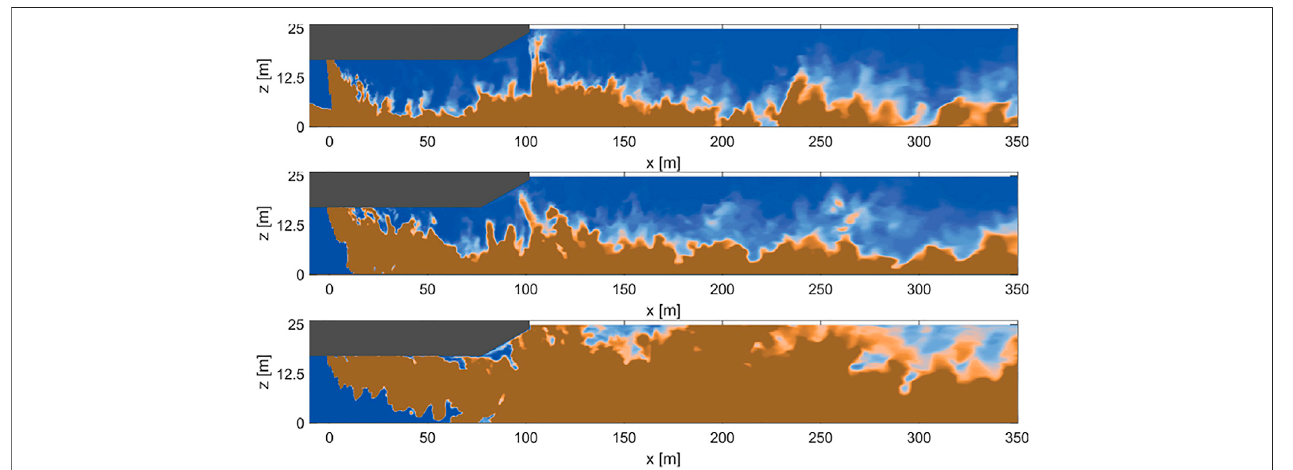
FIGURE 6 | Illustration of the in fl uence of the cross fl ow velocity on TSHD over fl ow dredge plume mixing (de Wit et al., 2014a, b) for three different u cf (0.5 m/s, 1.5 m/s and 3 m/s respectively, γ = 0.6 γ = 1.3 γ = 3.8) with all else similar (Ri = 1.2). The propellers of the TSHD are included in the simulation and by entrainment pull some of the plume